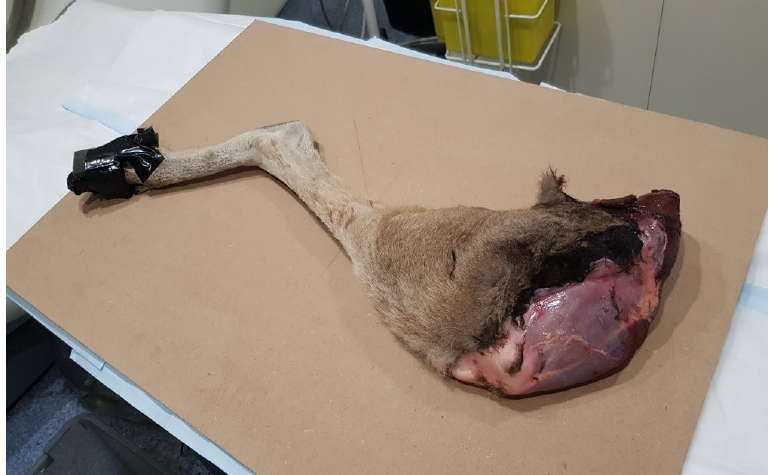
Figure 1. A defrosted limb ready for imaging. All limbs had the femoral head to end of tibia intact and were partly degloved (as sourced).